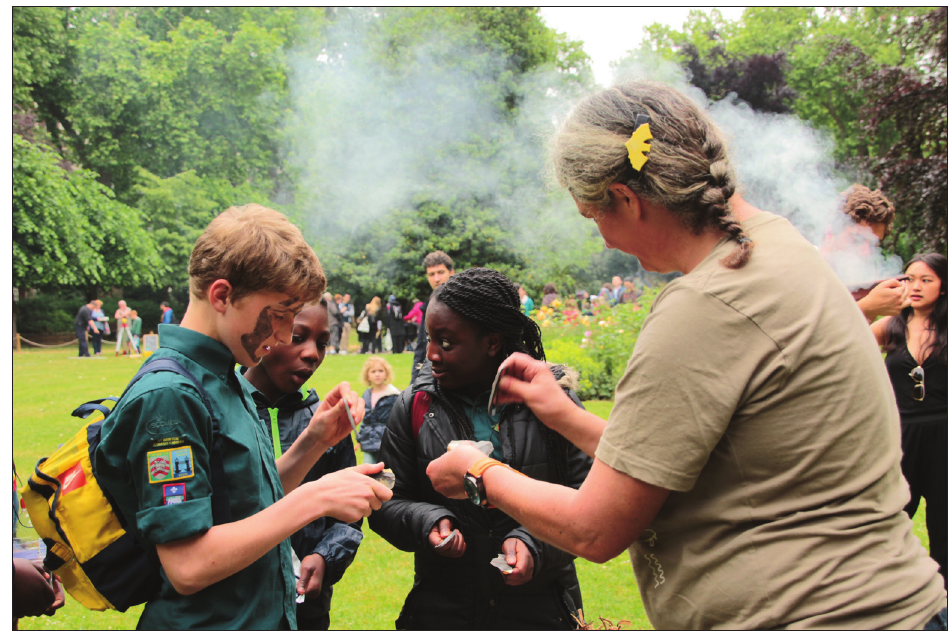
Figure 3: World Archaeology Festival: Ulrike Sommer demonstrating fire-making to the 1st Brixton (Corpus Christi) Scout Group (Photo Lisa